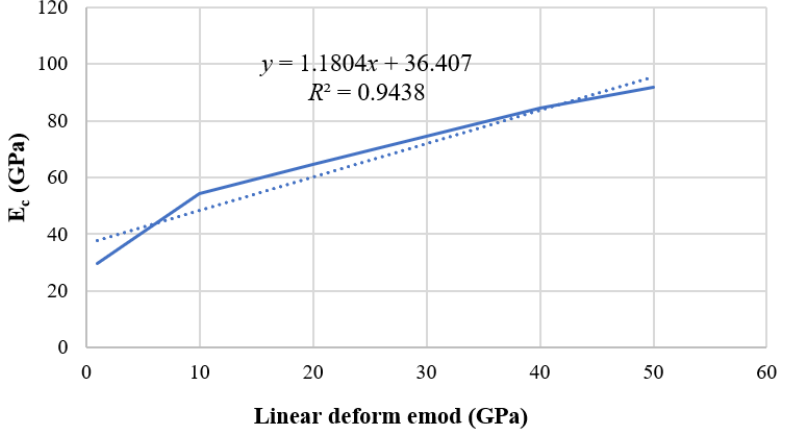
Figure 8. Calibration of Modulus of Elasticity in Uniaxial Compression, ( a ) stress strain curve, ( b ) break mode.